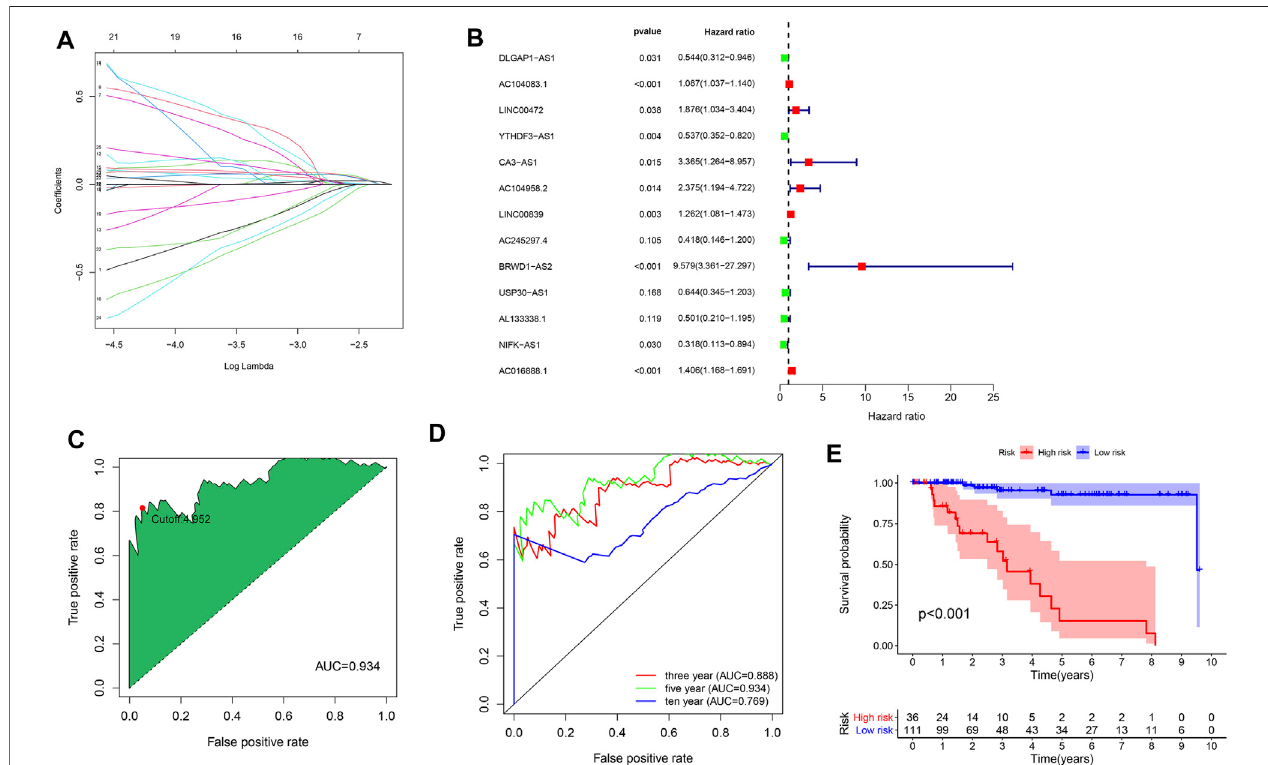
FIGURE 5 | Construction of the irlncRNA prognostic model. (A) Lasso regression analysis. (B) Forest map of identi fi ed irlncRNAs by Cox proportional hazard regression. (C) ROC curve was plotted with the AUC value and optimal cutoff value. (D) The 3-, 5- and 10-year ROC curves were mapped with AUC values. (E) KMA between the high- and low-risk groups, p <